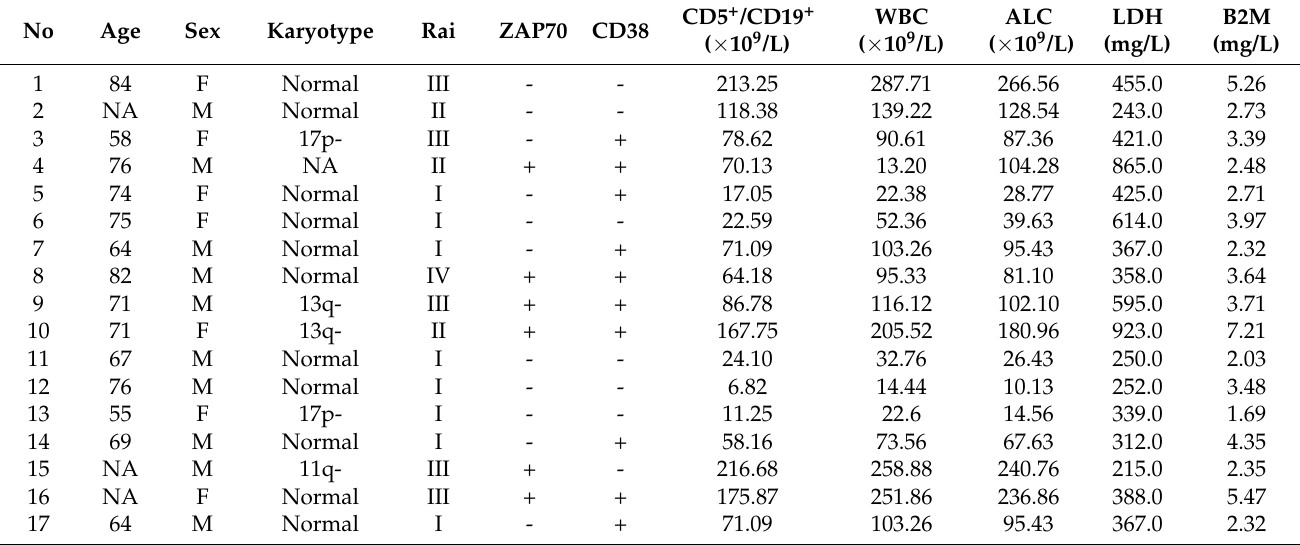
Table 2. Clinical characteristics of CLL